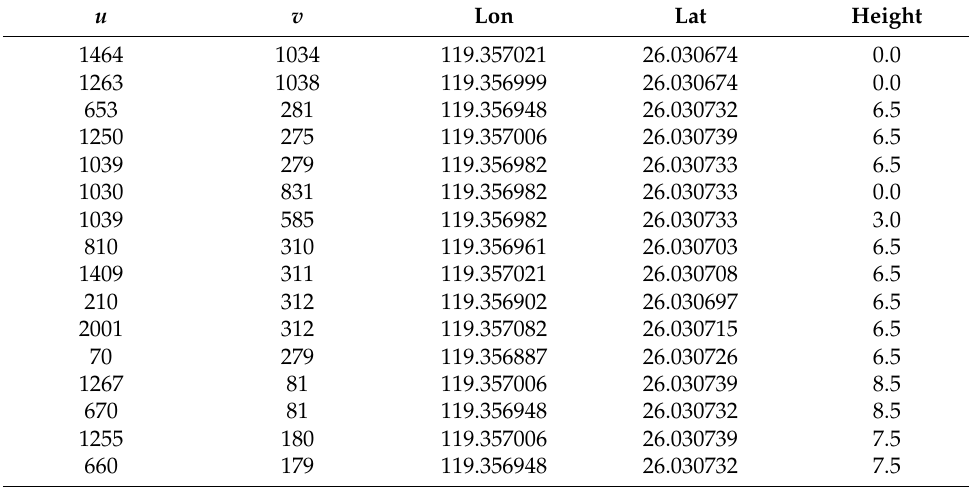
Table 3. Scene B experimental data.